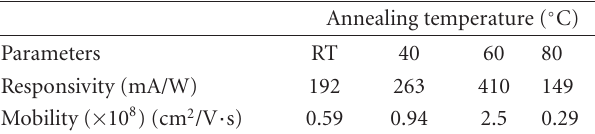
Table 2: Electrical parameters of blend